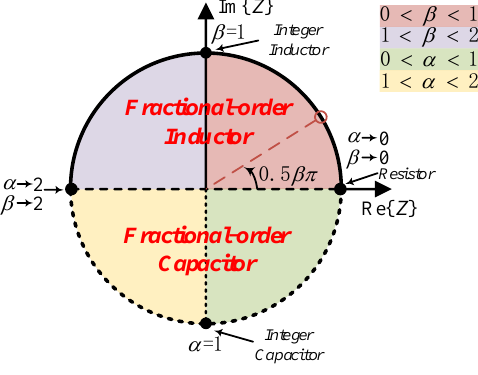
Figure 2. Fractional-order